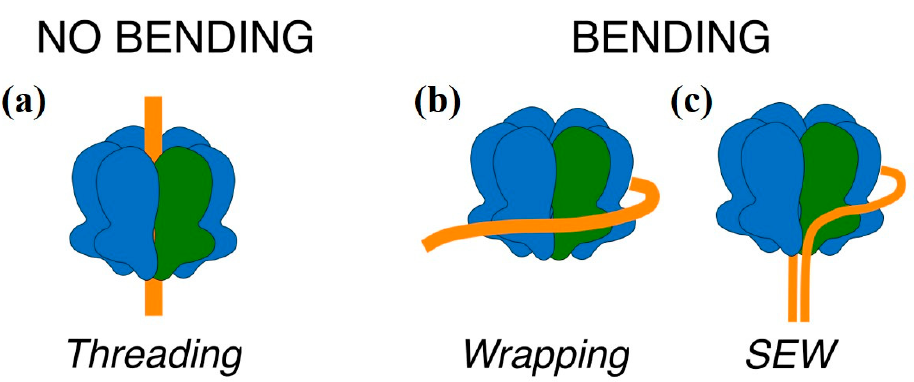
Figure 8. A schematic representation of the possible modes of interaction between MCM helicases and DNA. The MCM helicase is shown in blue, with a single monomer highlighted in green (as in Figure 1) and the DNA in orange. ( a ) The canonical mode of binding of hexameric ring helicases/translocases, with the ssDNA or dsDNA threading through the central channel; ( b ) the dsDNA wrapping around the external surface of the ring and interacting with subdomain A, as visualized by a low resolution CryoEM analysis [26]; ( c ) the strand-exclusion and wrapping model (SEW) in which one strand threads through the central channel, and the excluded strand wraps around the external surface of the hexamer.